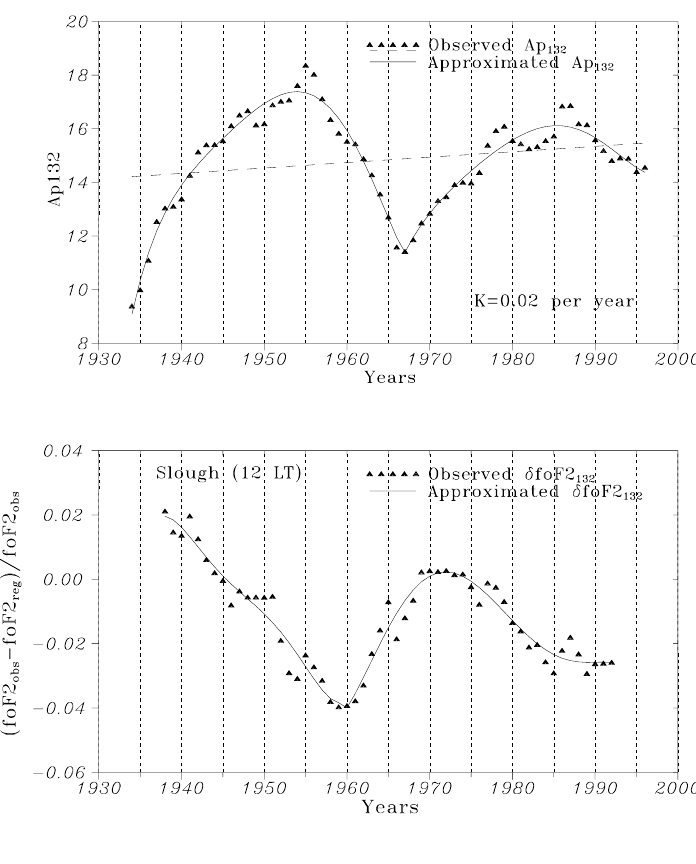
Fig. 2. Observed and polynomial ap- proximated Ap 132 and δ fo F2 132 varia- tions used in the trend analysis. Dashed line is a linear, very long-term trend with the slope K = 0.02 per year in geomagnetic activity obtained over the observed Ap 132 variations. Note also a 4-year shift between the Ap 132 and δ fo F2 132